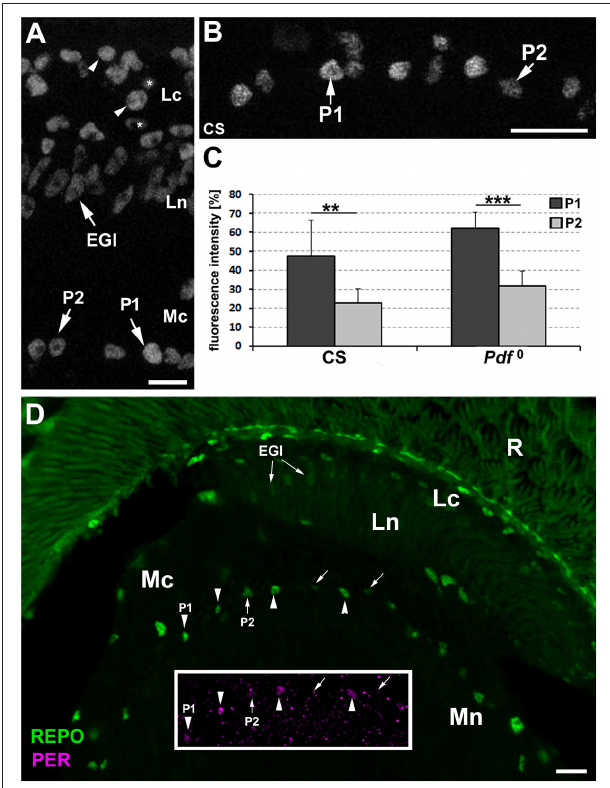
FIGURE 2 | (A) The cross section of the lamina and the distal part of the medulla of CS immunolabeled with anti-REPO antibody. The staining reveals differences in the intensity of REPO-specific fluorescence in various types of glia. In the lamina cortex (Lc) some glial cells show higher level of fluorescence (arrowheads) than others (asterisks). Fluorescence of the epithelial glia (EGl) in the lamina neuropil (Ln) is more uniform and rather low. The dMnGl show both higher (P1 cell) and lower (P2 cell) levels of REPO-specific fluorescence. Mc-medulla cortex. Scale bar: 5 µ m. (B) The P1 and P2 cells of the REPO-positive dMnGl are arranged in almost alternating order. Scale bar: 10 µ m. (C) The average level of REPO-specific fluorescence ( ± SD ) of the P1 and P2 dMnGl in CS and Pdf 0 (** p < 0.01, *** p < 0.0001). (D) The frontal section of the lamina and the distal part of the medulla of CS labeled with anti-REPO and anti-PER (insert) antibodies. The nuclei of REPO-P1 cells (in the main picture, arrowheads) show strong PER-specific fluorescence (insert, arrowheads). The REPO- P2 cells (in the main picture, arrows) reveal weak or no PER-specific fluorescence (insert, arrows). R, retina; Lc, lamina cortex; Ln, lamina neuropil; EGl, the epithelial glia of the lamina; Mc, medulla cortex; Mn, medulla neuropil. Scale bar: 20 µ